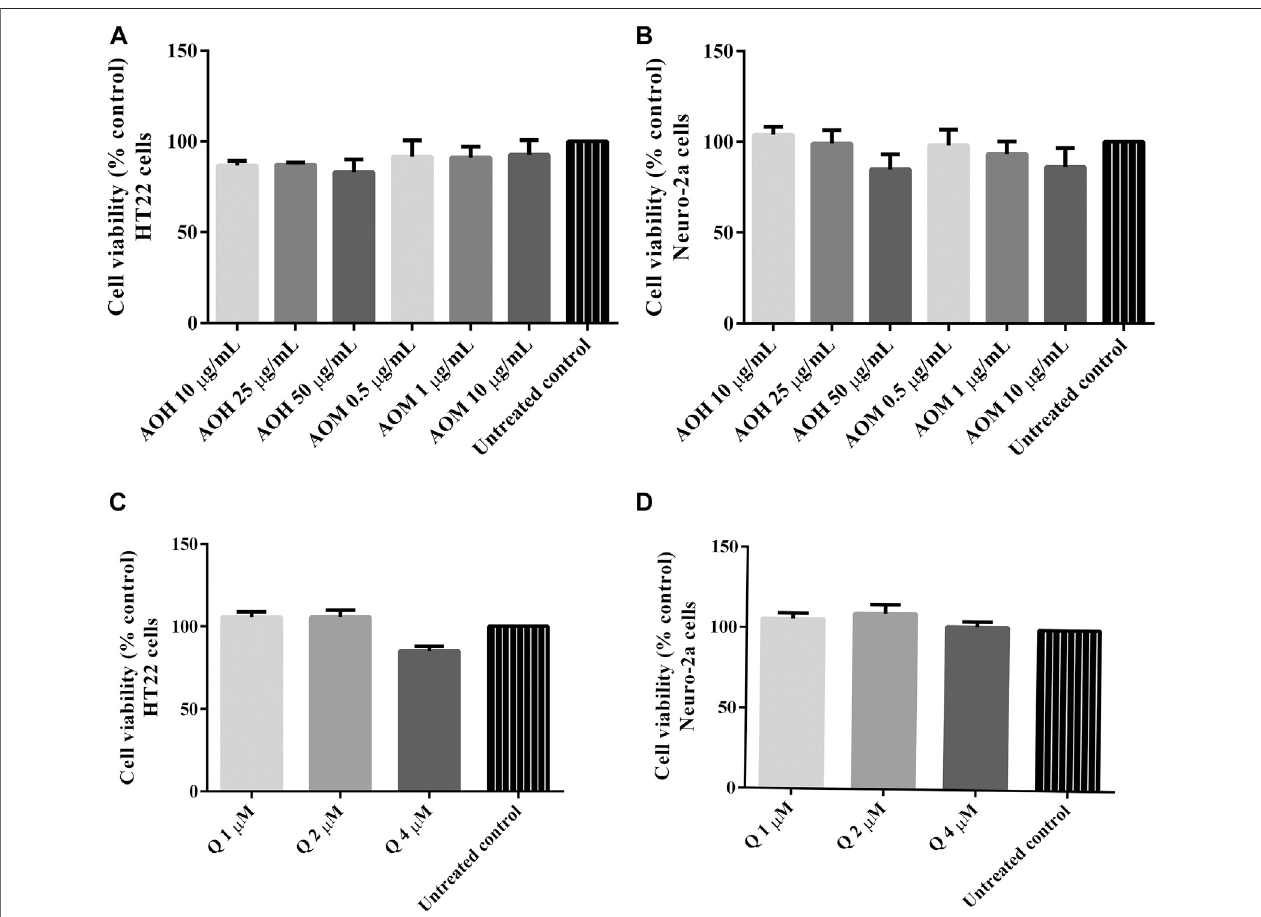
FIGURE 2 | Cytotoxicity effect of AO extracts in neuronal (HT22 and Neuro-2a) cells. The effects of AO extracts on cell viability of HT22 (A) and Neuro-2a (B) cells. The effects of quercetin on cell viability of HT22 (C) and Neuro-2a (D) cells. Cells were treated with different concentrations of the extracts or compounds for 48 h following MTT assay. The results are expressed as the means ± SEM of independent experiments ( n (cid:1) 3); p ≤ 0.001 compared to the untreated control.